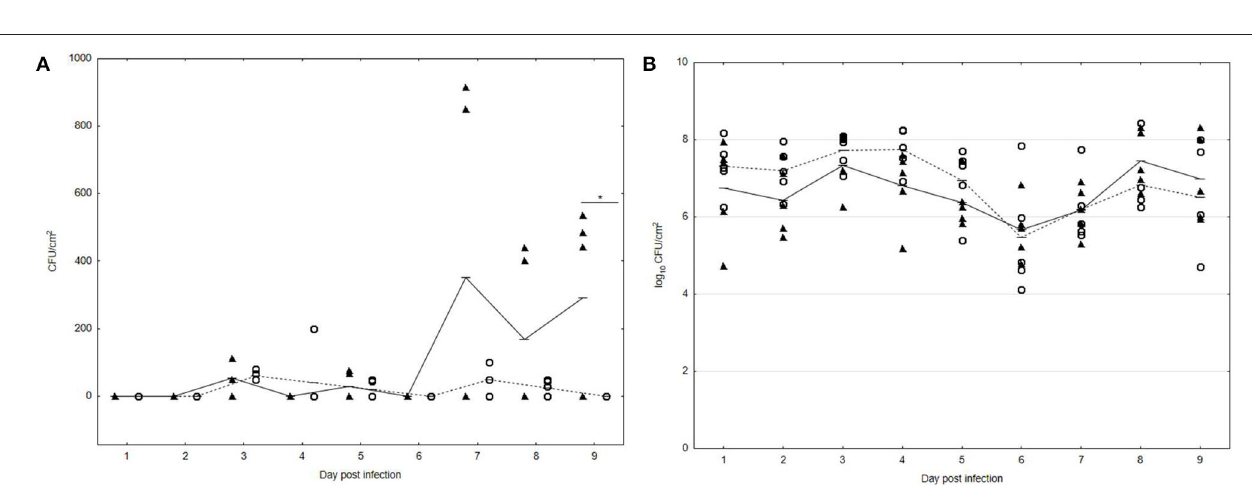
FIGURE 4 | Effect of phage cocktail UPWr_S134 on bacteria attached to the poultry drinker surface in an experimental chicken model. (A) Effect of phage cocktail UPWr_S134 on the number of S. Enteritidis 327 lux. (B) Effect of phage cocktail UPWr_S134 on the total viable count. Results for bacterial load show counts for individual drinkers plus the mean ( n = 5 per group). * p < 0.05 indicates a significant difference between control and treatment groups. Black triangles indicate control group 1 infected with S. Enteritidis 327 lux and empty circles indicate group 3 treated with both S. Enteritidis 327 lux and phage cocktail